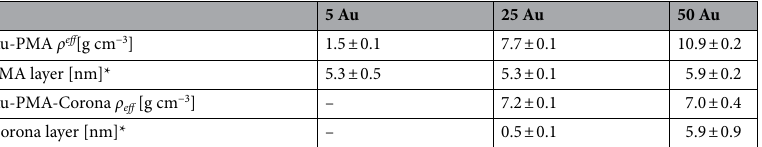
Table 2. PMA and PMA corona shell thickness on AuNPs calculated using a core shell model on DCS measurements. *PMA and biomolecular corona thickness are calculated by applying the core–shell model as indicated in the Methods